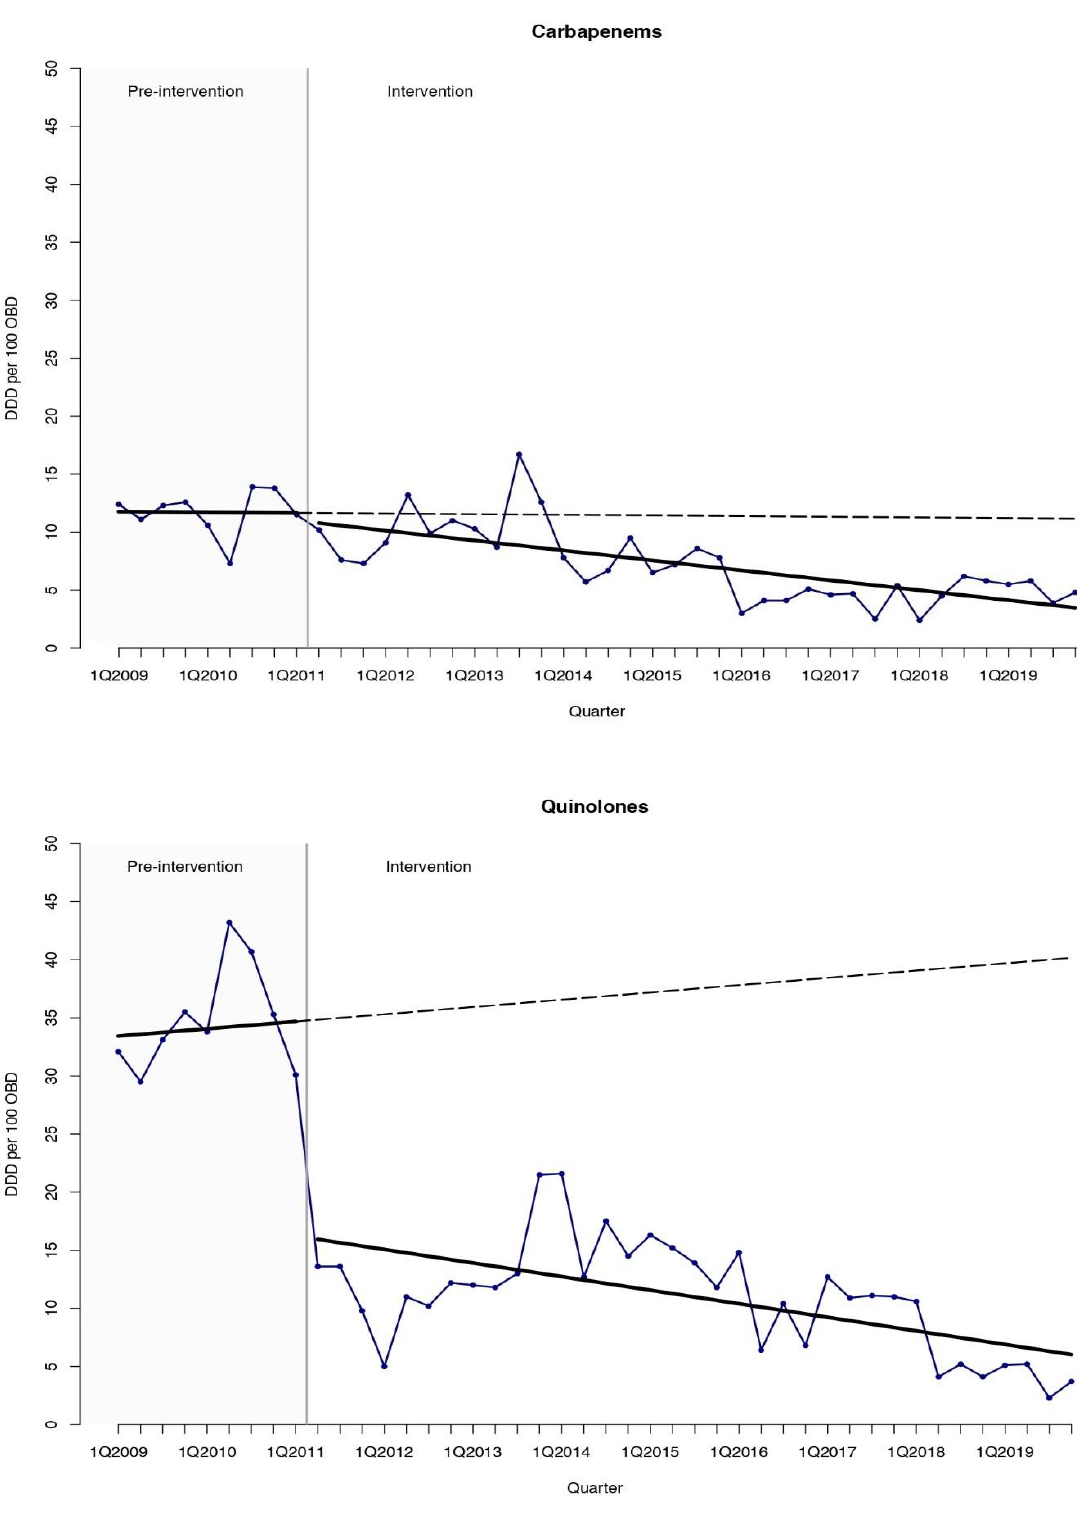
Figure 3. Interrupted time-series analysis of the trends in consumption for carbapenems and quinolones observed before and after the implementation of the antimicrobial stewardship program. Solid lines show the observed trend during the pre-intervention and intervention periods. Dashed lines show the expected trend after the intervention according to the pre-intervention values. DDD, defined daily doses. OBD, occupied bed days. Q, quarter.